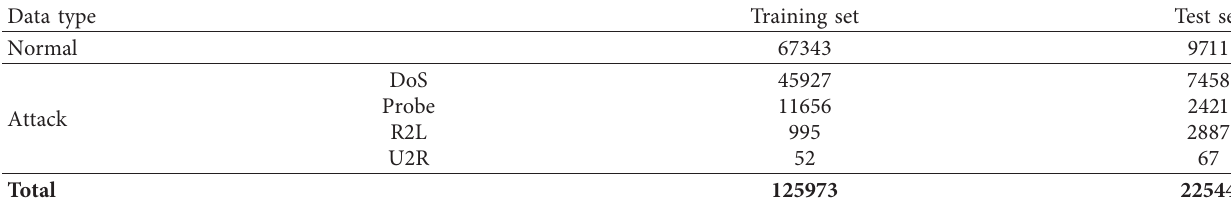
Table 3: NSL-KDD data